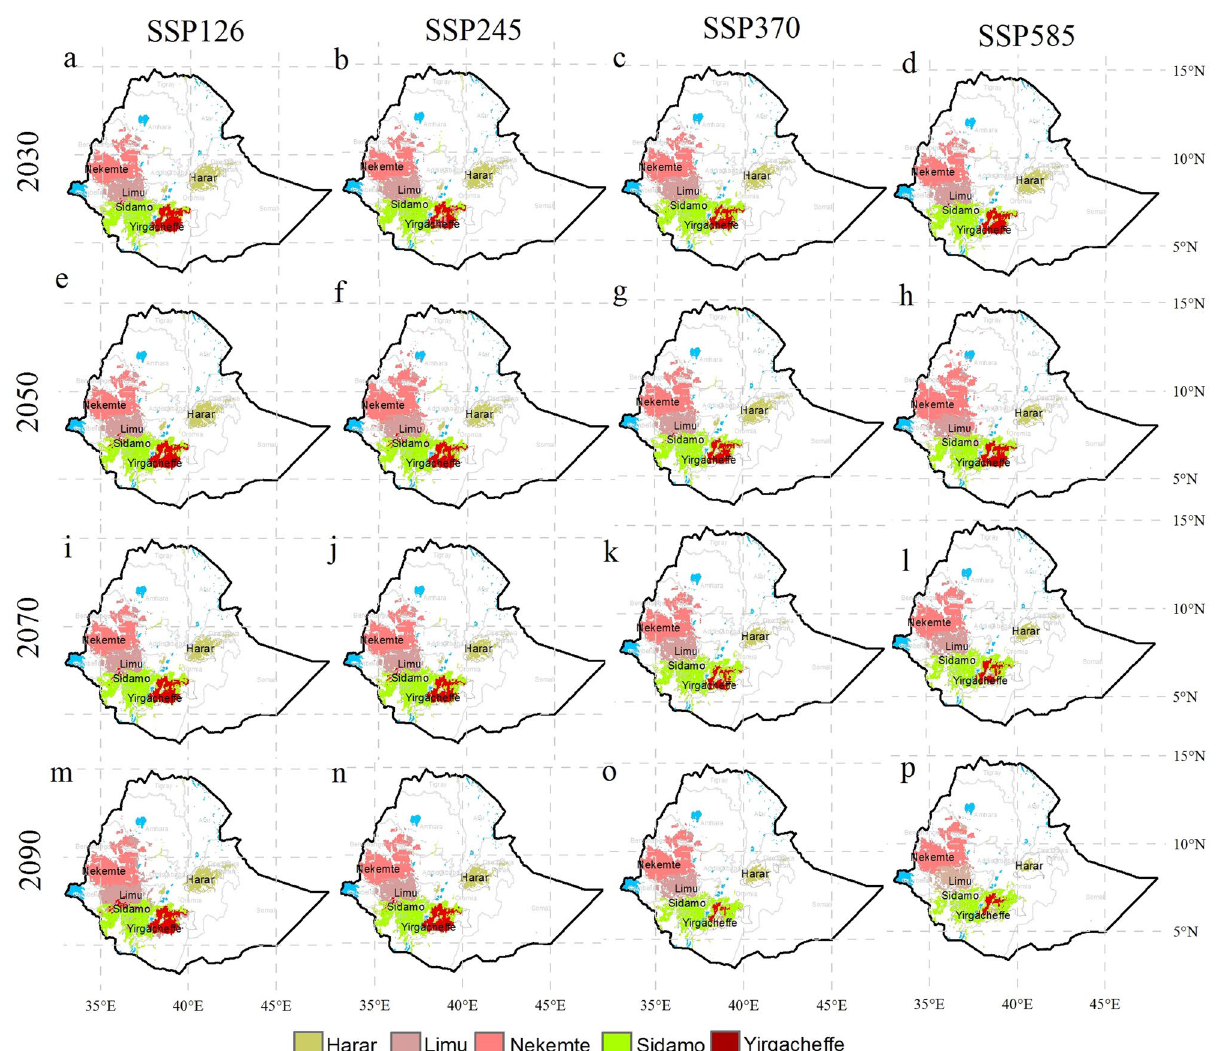
Figure 5. Maps showing the projected changes in the area suitable for growing specialty coffee in Ethiopia in the 2030s, 2050s, 2070s and 2090s. The results are obtained from four scenarios obtained from the ensemble model. The model results were exported into ArcGIS Software Version 10.2 (http:// deskt op. arcgis. com/ en/ arcmap) to generate the map in this